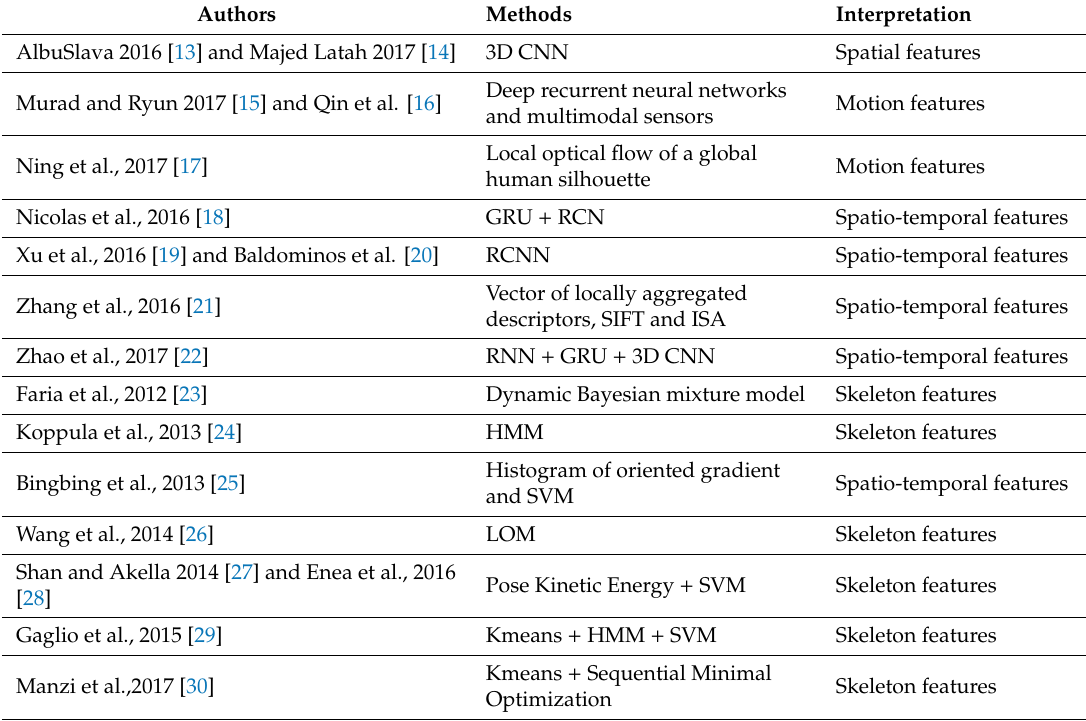
Table 1. State-of-the-art methods and their